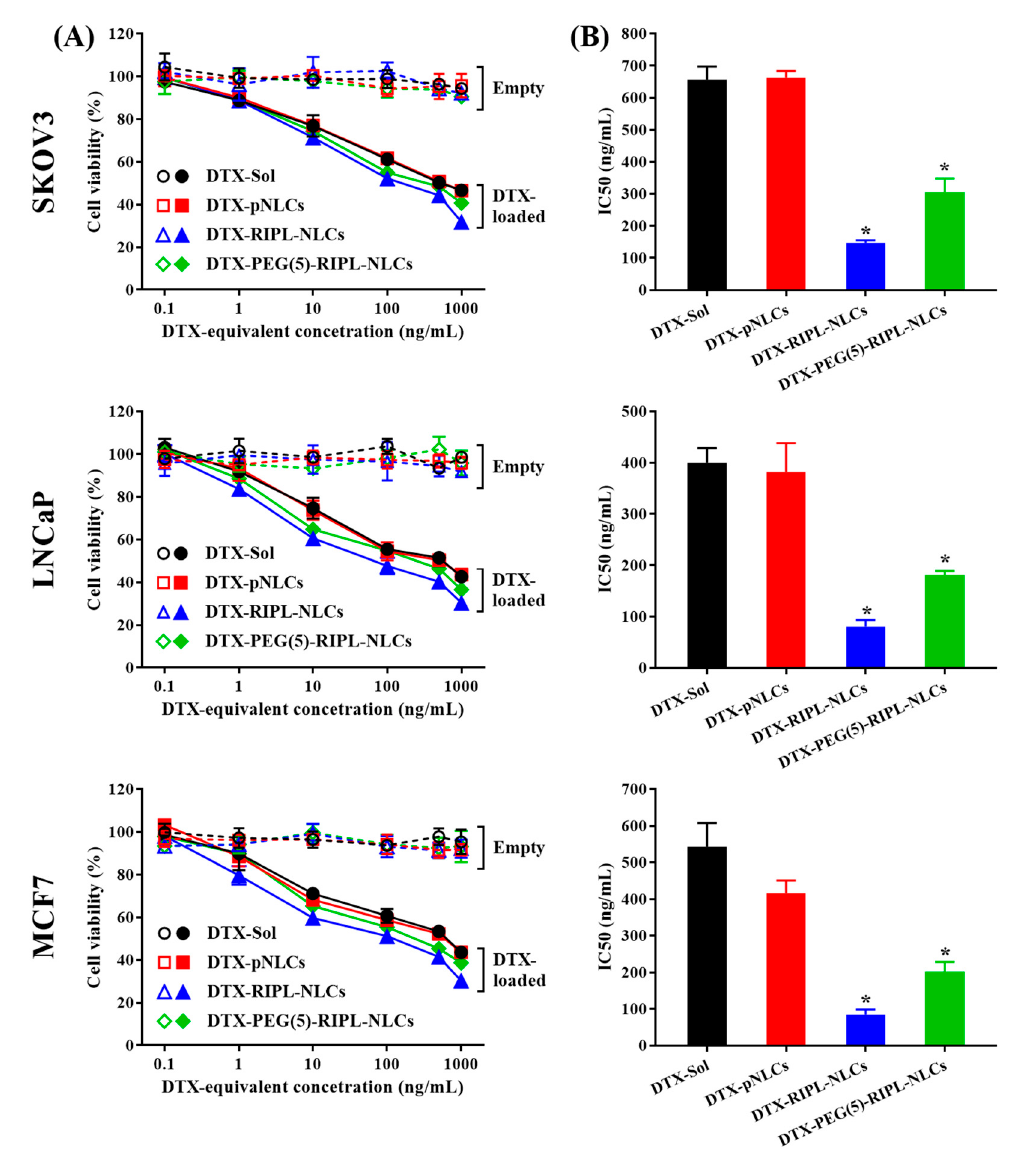
Figure 7. Cytotoxicity of the empty and DTX-loaded formulations for SKOV3, MCF7, and LNCaP cells. ( A ) Cell viability plotted against the log DTX-equivalent concentration. DTX-Sol ( ○ , ● ); DTX-pNLCs ( □ , ∎ ); DTX-RIPL-NLCs ( △ , ); DTX-PEG(5)-RIPL-NLCs ( ◊ , ♦ ). Opened for empty formulations and filled for DTX-loaded formulations; ( B ) IC 50 values of DTX-loaded formulations. Data are the mean ± SD ( n = 3). * p < 0.05 versus DTX-pNLCs.